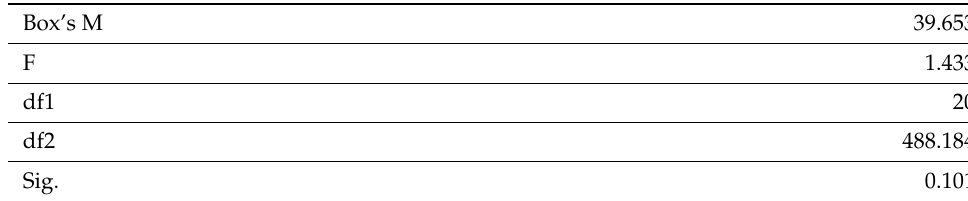
Table 2. Box’s Test of Equality of Covariance Matrices.